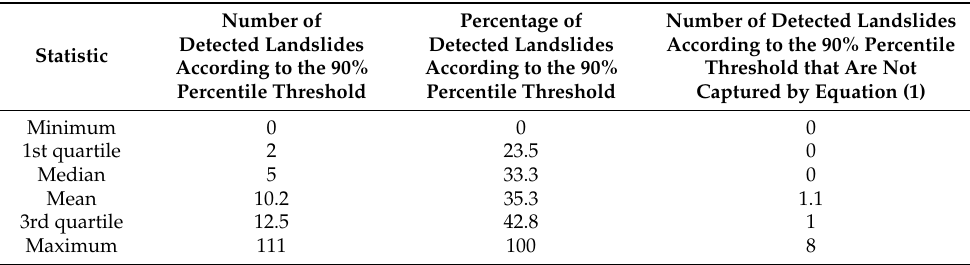
Table 2. Descriptive statistics for the performance of the simple 90% percentile threshold. For the number of landslides in the sub-catchment please refer to Table